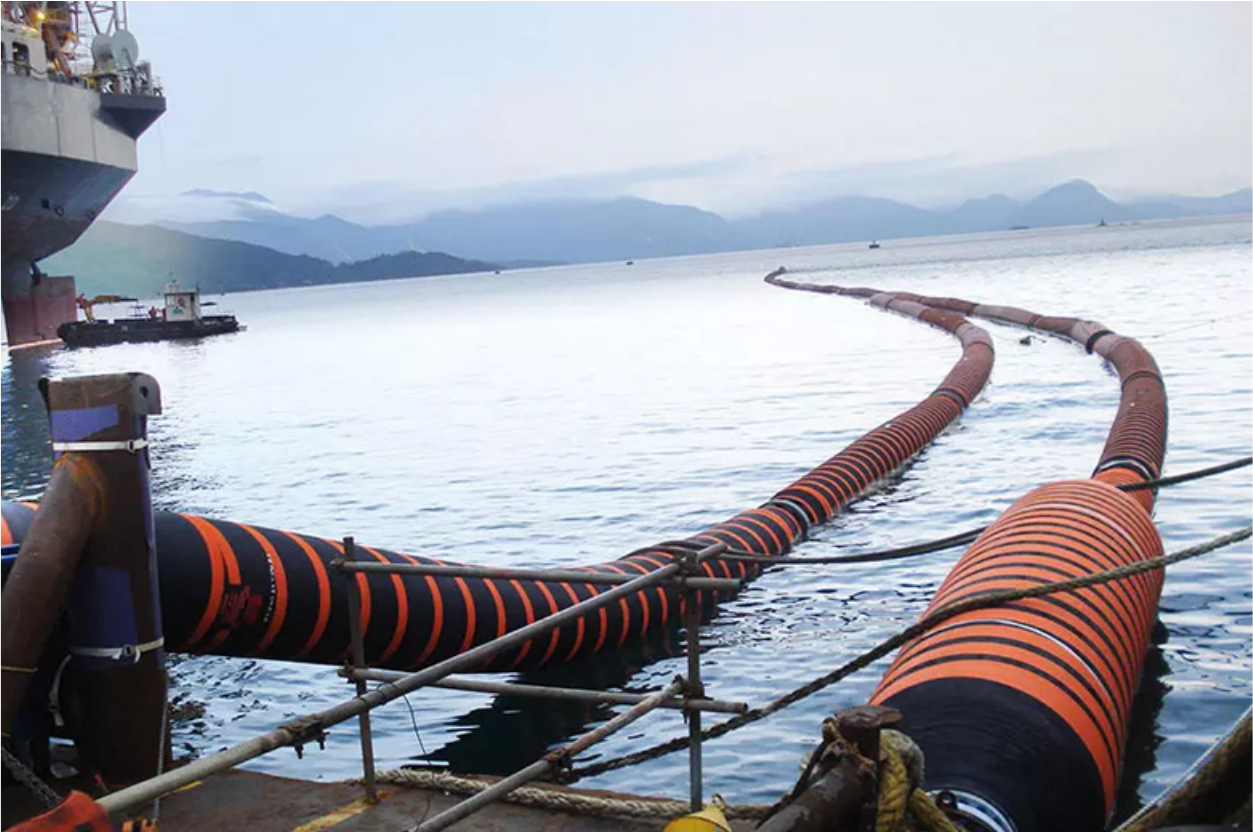
Figure 1. Trelleborg’s Sealine floating hose during installation to a supply vessel. (Sealine is a product type that is specifically designed for floating hose configurations, while Reeline is a product type that is specifically designed for reeling hose configurations. Both Sealine and Reeline are hose products made by Trelleborg, a hose manufacturer. Courtesy: Trelleborg; adapted with permission.).